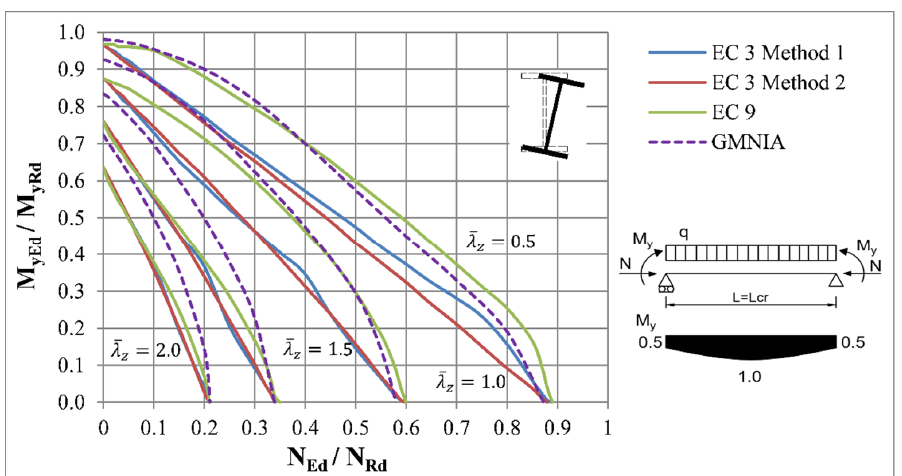
Figure 18. Interaction curves for laterally unrestrained beam-columns with IPE 100 cross-section with restrained warping.